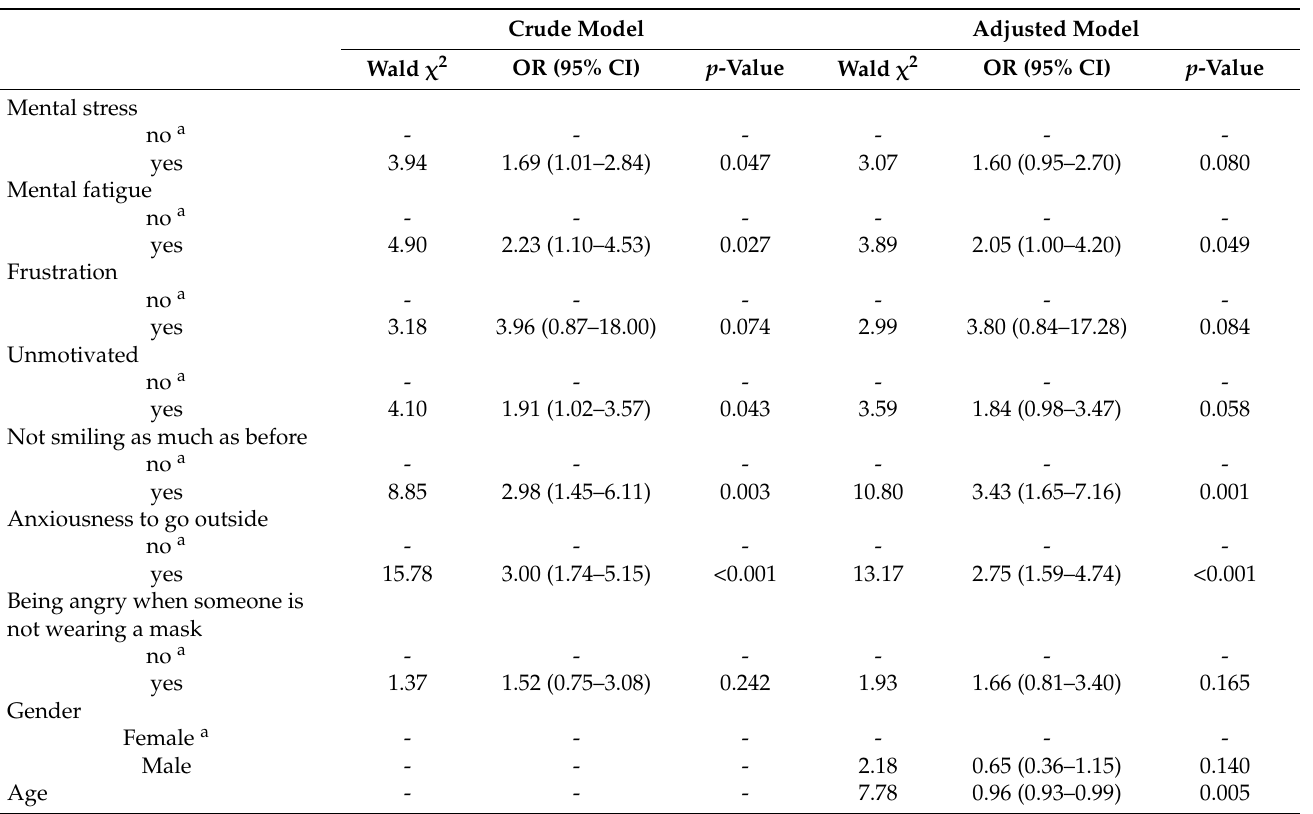
Table 4. Association between frequency of going out and psychological condition changed since before the COVID-19 pandemic. Crude Model Adjusted Model Wald χ